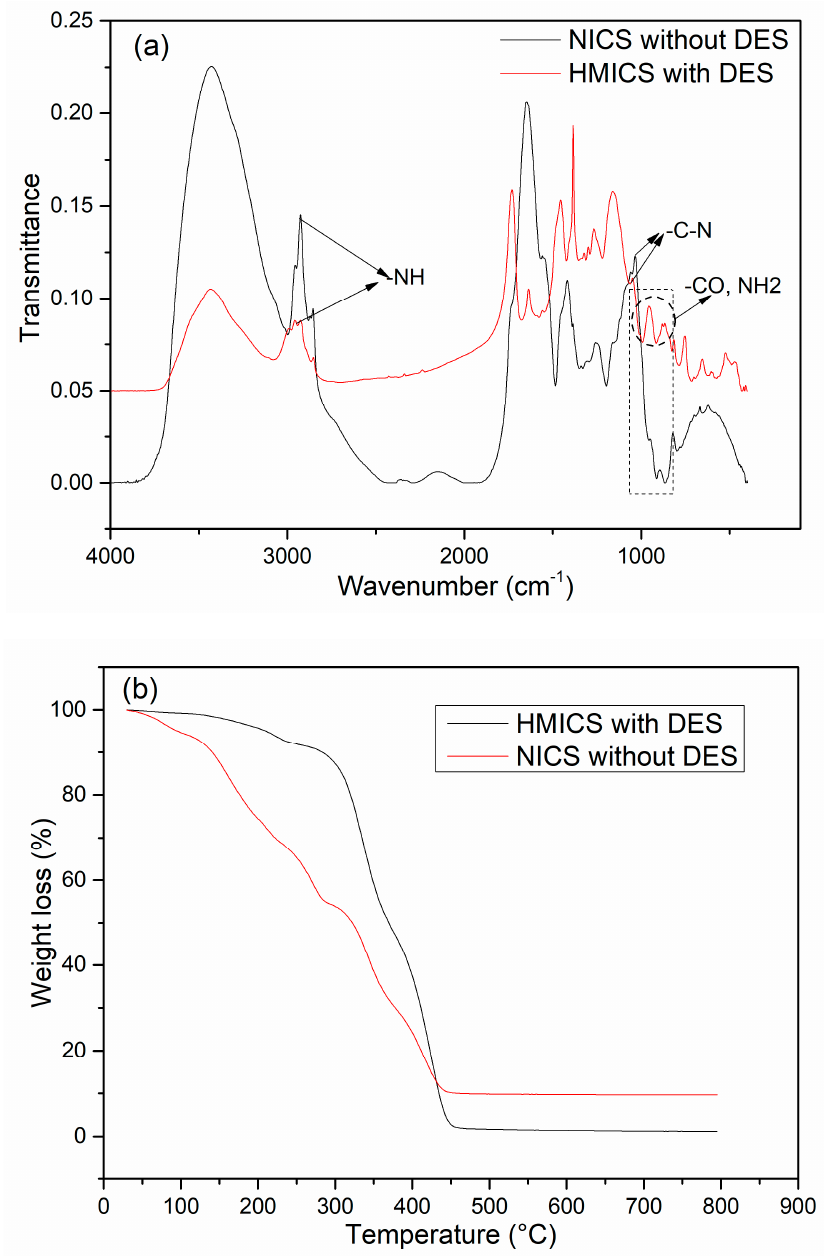
Figure 4. FT-IR spectra ( a ) and thermogravimetric analysis ( b ) of HMICS with DES, and NICS without DES.